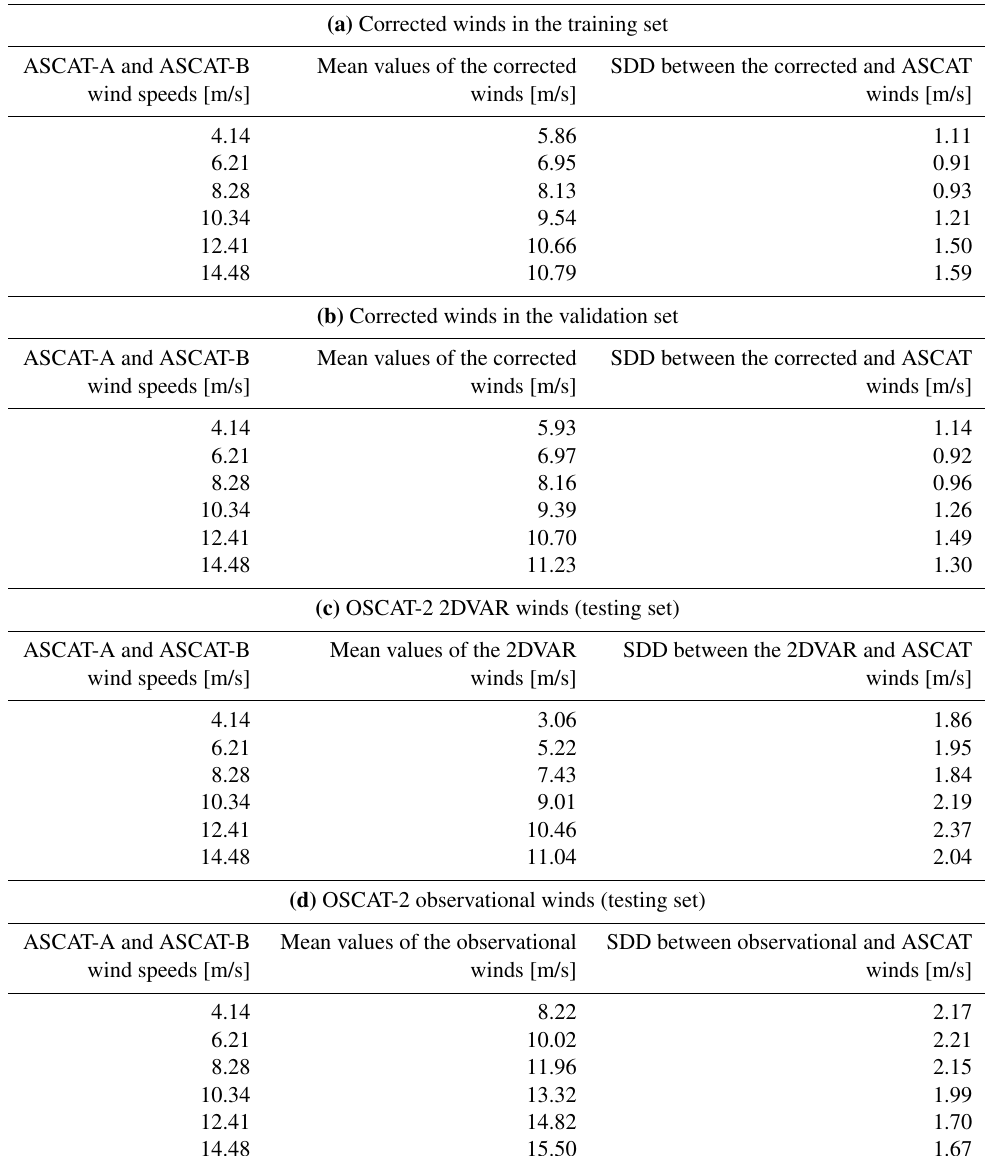
Table 2. Corresponding mean and standard deviation of difference (SDD) statistics to Fig. 3a–d. (a) Corrected winds in the training set ASCAT-A and ASCAT-B Mean values of the corrected SDD between the corrected and ASCAT wind speeds [m/s] winds